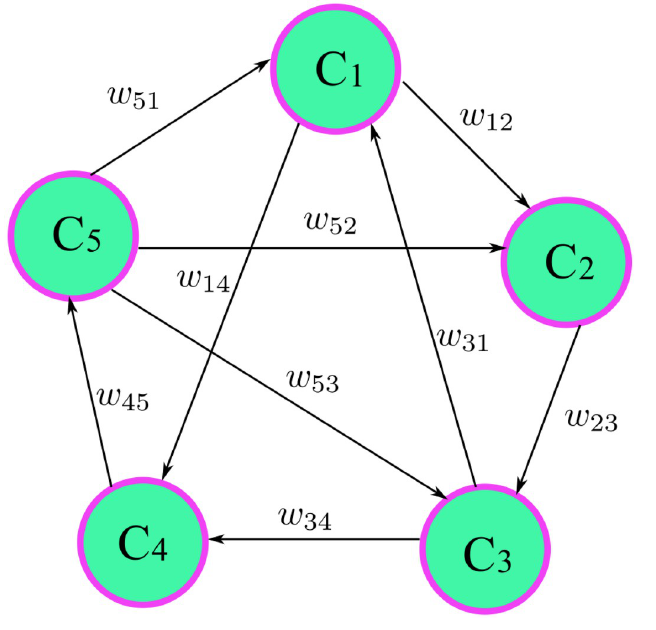
Fig 1. The structure of